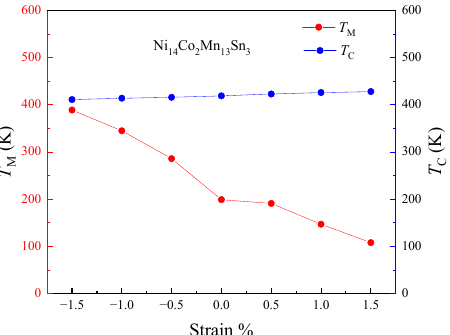
Figure 6. Strain change ( − 1.5~1.5%) of the T M and the T C in Ni 14 Co 2 Mn 13 Sn 3 . The total density of states (TDOS) of austenite and martensite in Ni 14 Co 2 Mn 13 Sn 3 and the partial density of states (PDOS) of Mn Mn and Mn Sn of austenite and martensite in Ni 14 Co 2 Mn 13 Sn 3 are shown in Figures 7–9 respectively to further illuminate the physical mechanism of the MPT and magnetic properties [55,56]. In addition, the phase stability is strongly dependent upon the TDOS at the Fermi level plays (E F ) [57,58]. Usually, the low TDOS indicates the stable phase in Ni 14 Co 2 Mn 13 Sn 3 FSMAs. Figure 7a shows that the TDOS at E F of strain ( − 1.5%, 1.5%) is similar in Ni 14 Co 2 Mn 13 Sn 3 austenitic phases. The strain has a weak effect on austenitic phase stability. Moreover, for martensitic phases, the TDOS of − 1.5% strain is lower than the TDOS of 1.5% strain at E F , as shown in Figure 7b. The − 1.5% strain decreases the instability of the Ni 14 Co 2 Mn 13 Sn 3 martensitic phase. Then, the instability of the martensitic phase decreases, and the stability of austenitic phases show a few changes. In addition, austenite is a peak at E F , while martensite is a pseudopotential valley. It shows that the stability of austenite is lower than that of martensite, which leads martensite also explains the existence of large Δ M . In conclusion, the strain cannot change the magnetic properties of Ni 14 Co 2 Mn 13 Sn 3 FSMAs. The Ni 14 Co 2 Mn 13 Sn 3 FSMAs meet the to the MPT according to the Jahn teller splitting effect. The results show that strain can condition of the stable MFIMT. tune the T M of Ni 14 Co 2 Mn 13 Sn 3 FSMAs.